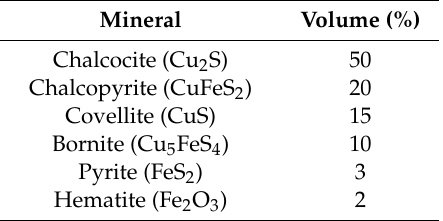
Table 3. Percentages of the minerals identified by optical microscopy.